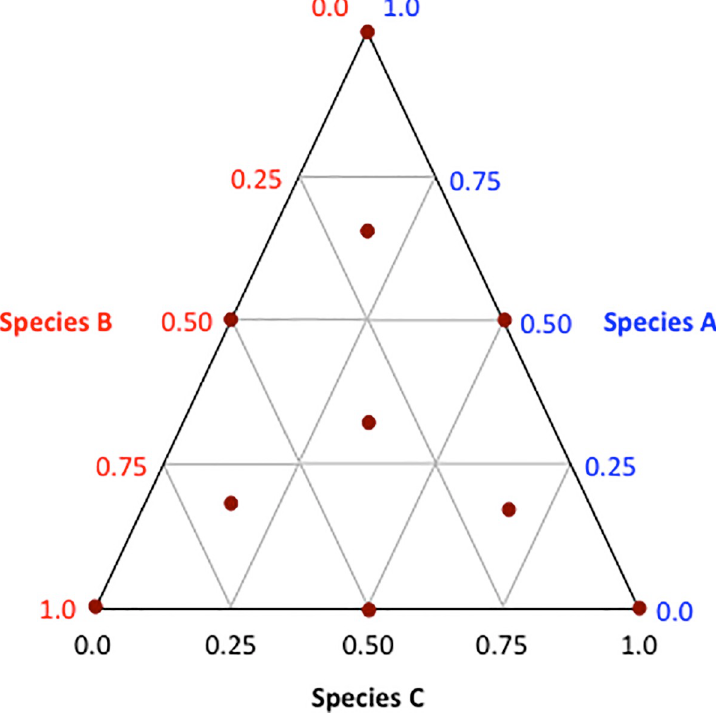
Fig 1. Design space for a mixture of 3 conservation plant species. The coordinates of points within the mixture space are expressed as proportions summing to 1. Each side of the triangular space corresponds to all of the proportions of a single plant species within the mixture. The red dots signify the proportional sampling points (treatments) measured in each experiment. Replications were performed over time.